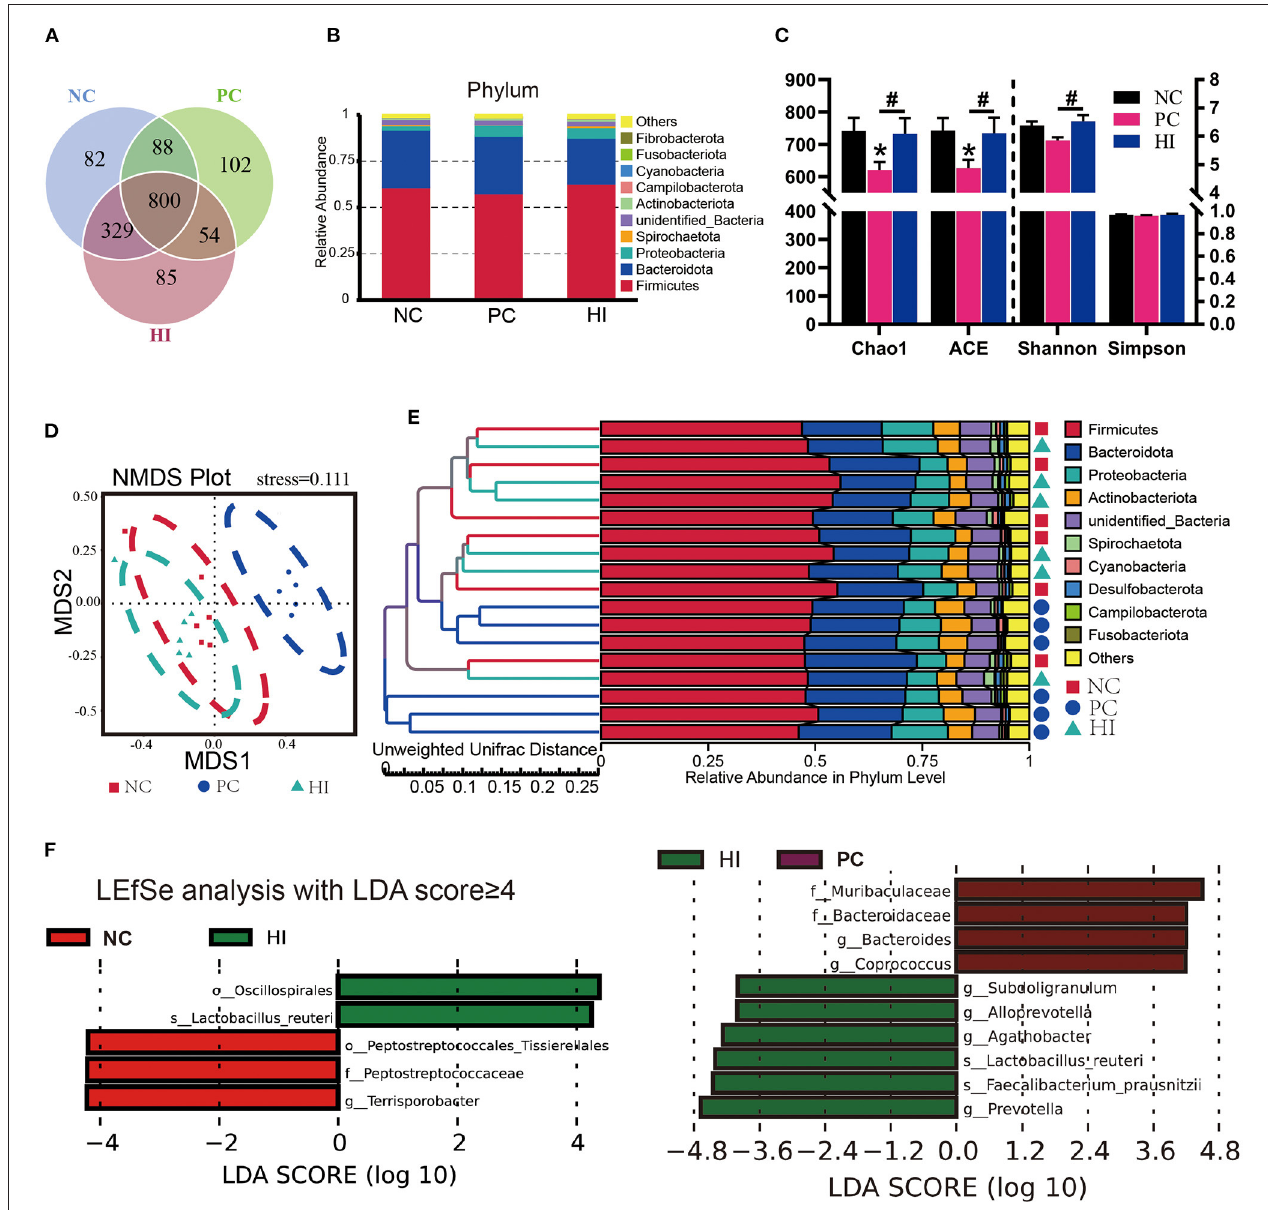
FIGURE 5 | Effect of dietary Hermetia illucens larvae on the microbial communities in the colonic contents of weaned pigs. (A) Venn diagram illustrating common and special OTUs distributed among the three groups. (B) The phylum-level species histogram shows the top 10 phylum-level species. (C) Species diversity and homogeneity were evaluated using Chao1, ACE, Shannon’s, and Simpson’s indices. (D) OUTs-based NMDS plot. (E) UPGMA clustering was conducted based on unweighted unifrac distance. (F) Significantly different biomarkers in the three groups. n = 6. * p < 0.05 compared with NC, # p < 0.05 HI compared with